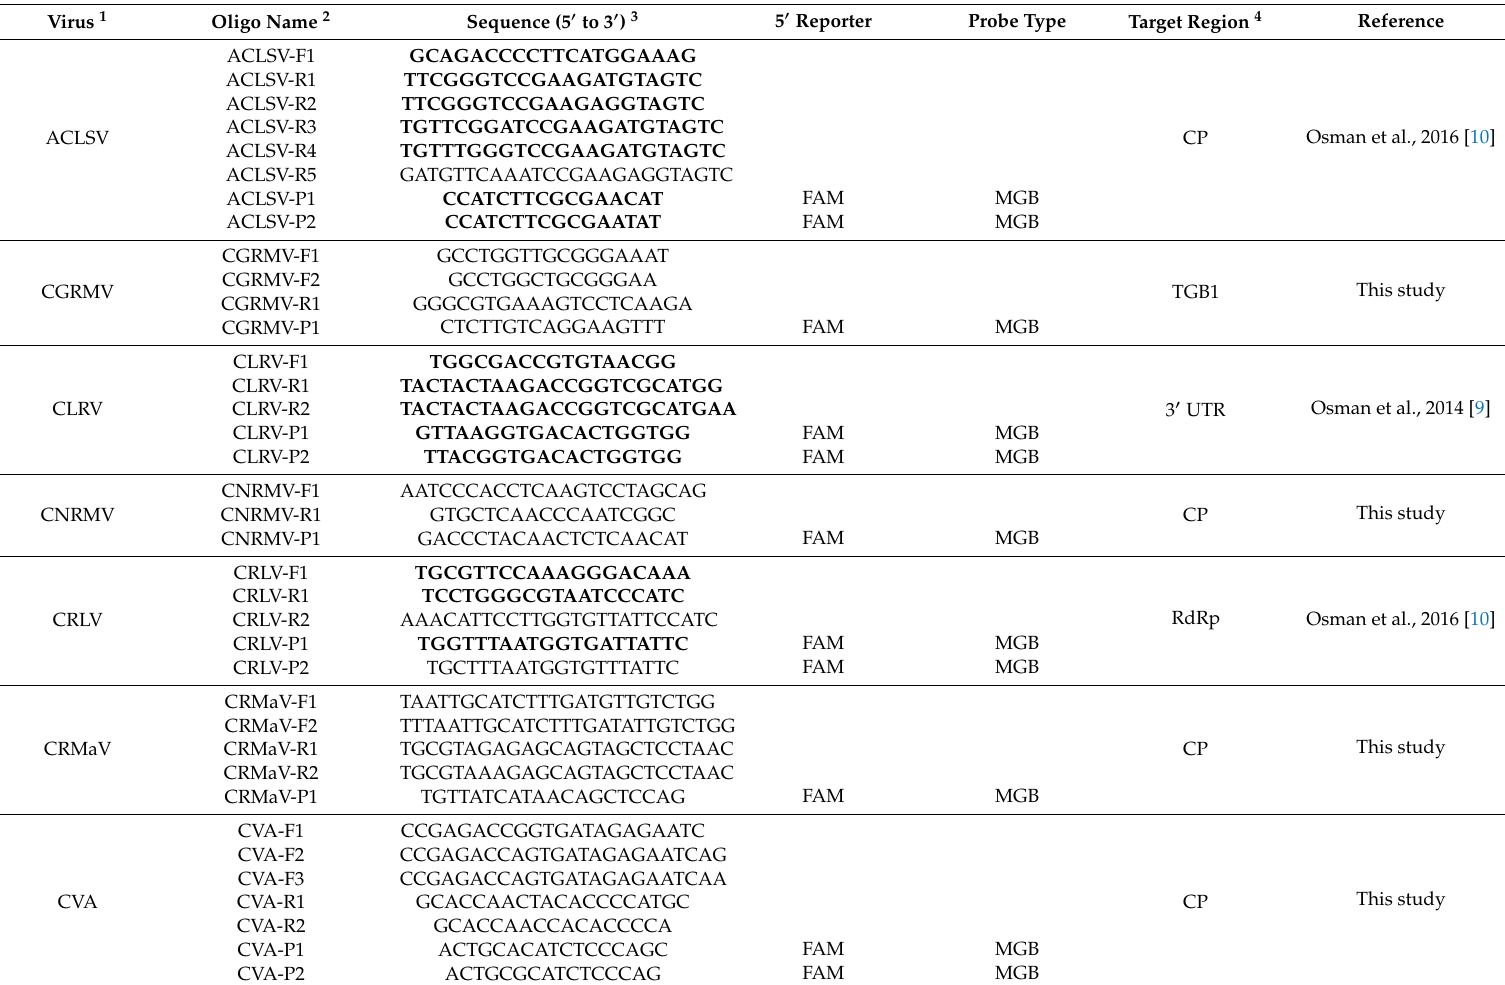
Table 2. Updated or newly designed assays for detection of Prunus -infecting